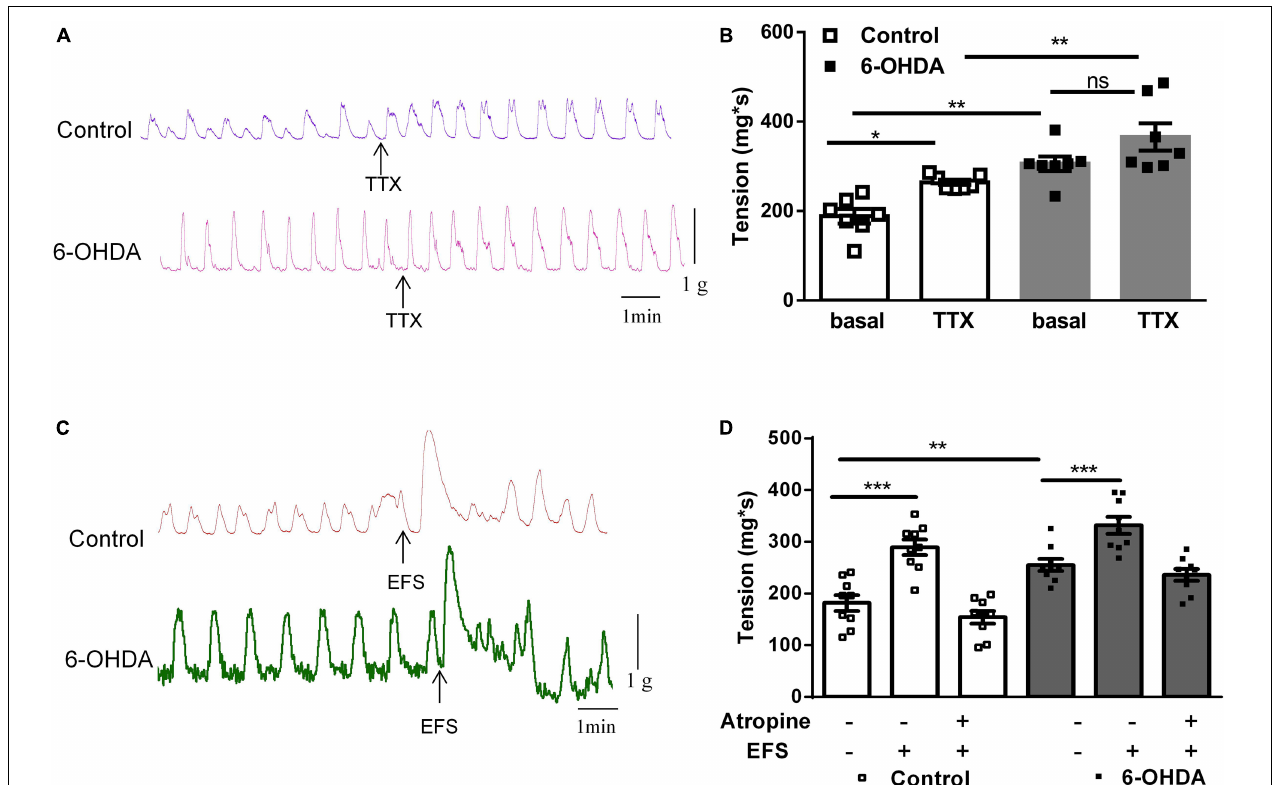
FIGURE 2 | Effect of tetrodotoxin (TTX) and electrical field stimulation (EFS) on the contraction of colorectum. (A) Representative tracings of in vitro colorectal contraction when pretreatment with TTX (1 µ M). (B) Bar charts show the contraction of colorectal ( n = 7). (C) Representative tracings of EFS-invoked colorectal contraction. (D) Bar charts show the contraction of the colorectum in response to EFS alone or in combination with the muscarinic receptor antagonist atropine (1 µ M) ( n = 9). * P < 0.05, ** P < 0.01, *** P < 0.001.